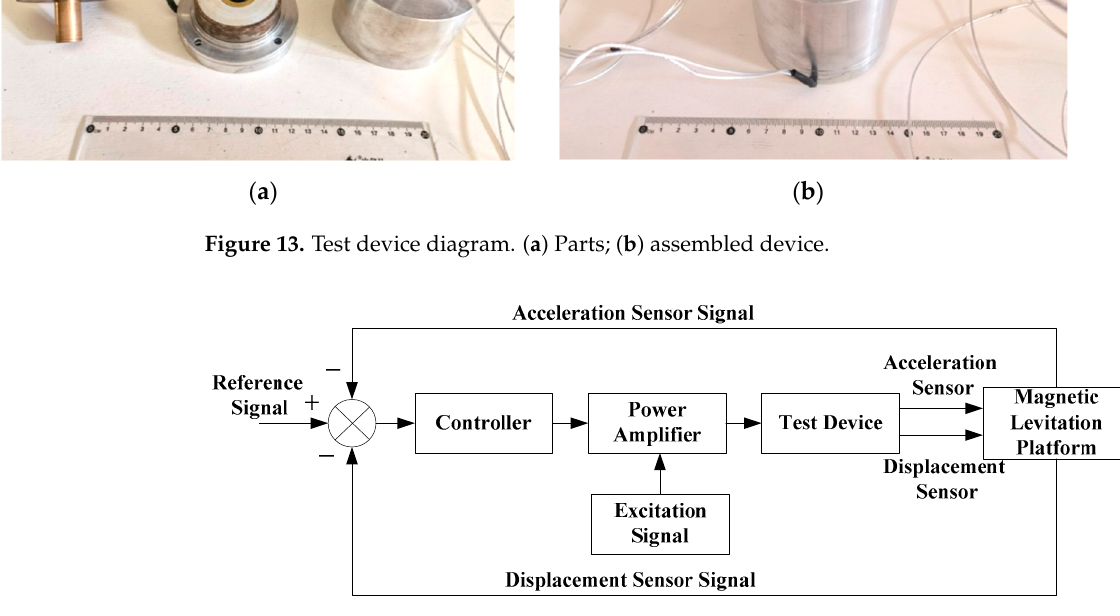
Figure 16. Excitation voltage and displacement voltage signal in stable suspension state. The data in Table 2 are the acceleration values of the mass block and the base at the X -axis, Y -axis and Z -Axis. They were measured by the acceleration sensor after the mass block was suspended stably, and a 1.5 V sinusoidal excitation voltage was added to the